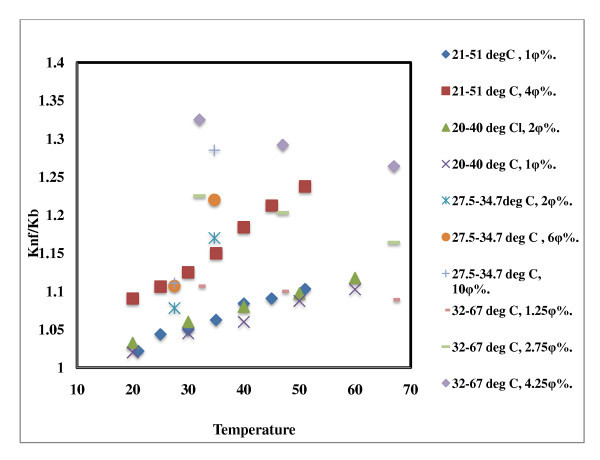
Effect of temperature on thermal conductivity of Al2O3-based nanofluids. 21°C to 51°C, 1 φ% [7]; 21°C to 51°C, 4 φ% [7]; 20°C to 40°C, 2 φ% [20]; 20°C to 40°C, 1 φ% [20]; 27.5°C to 34.7°C, 2 φ% [13]; 27.5°C to 34.7°C, 6 φ% [13]; 27.5°C to 34.7°C, 10 φ% [13]; 52°C to 67°C, 1.25 φ% [15]; 52°C to 67°C, 2.75 φ% [15]; 52°C to 67°C, 4.25 φ% [15].